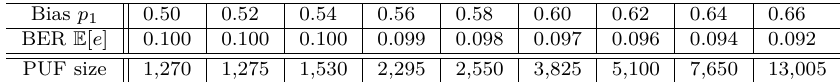
Table 1: PUF sizes required for reliable 128-bit key generation with buffering entropy (Values are derived from [DGV + 16]) Bias p